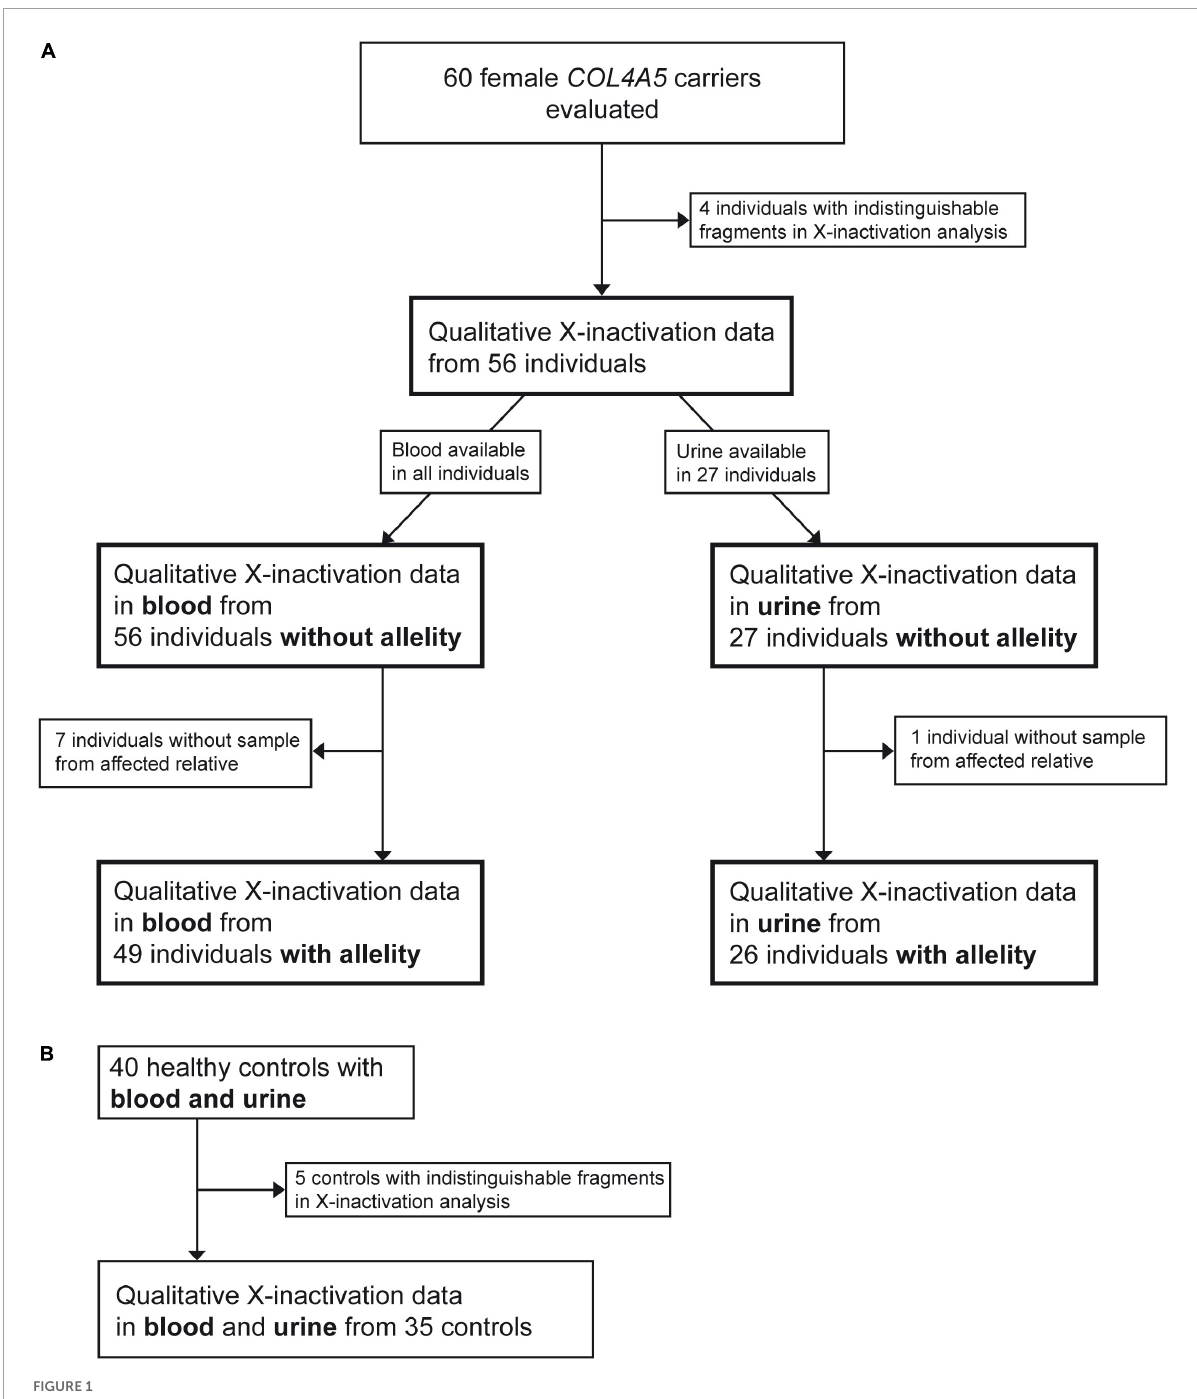
FIGURE1 Flowchart illustrating the recruitment process of participants. Figure shows recruitment procedure for individuals with a heterozygous disease-causing COL4A5 variant (A) and healthy controls (B)